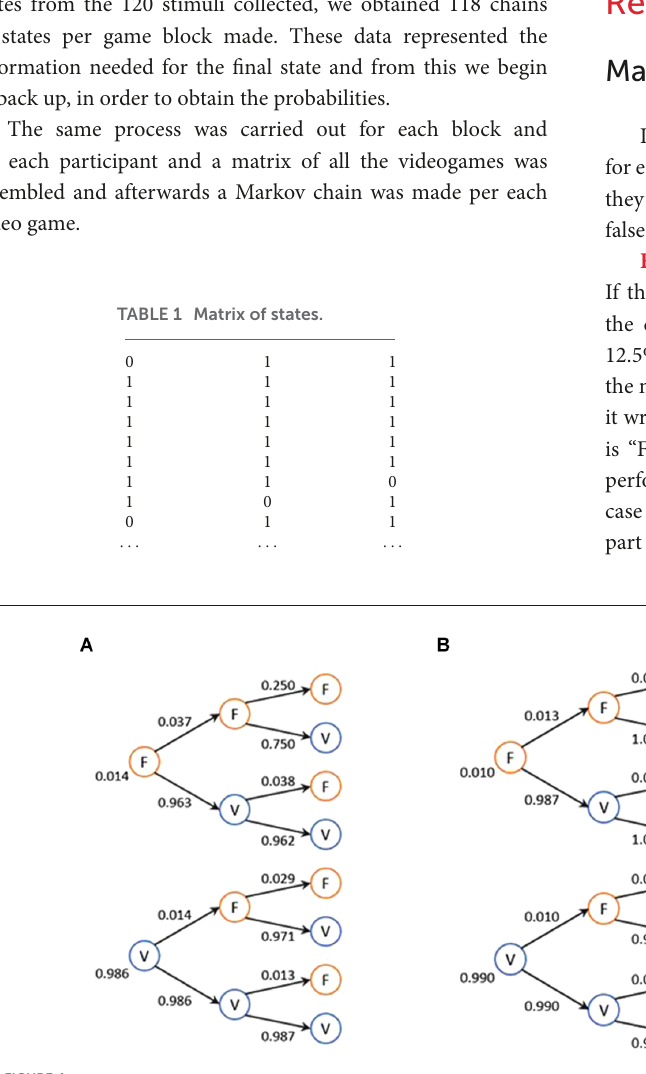
FIGURE4 States in the AR game for all participants (A) in the 2D game f. (B) In the 3D game. (C) In the AR